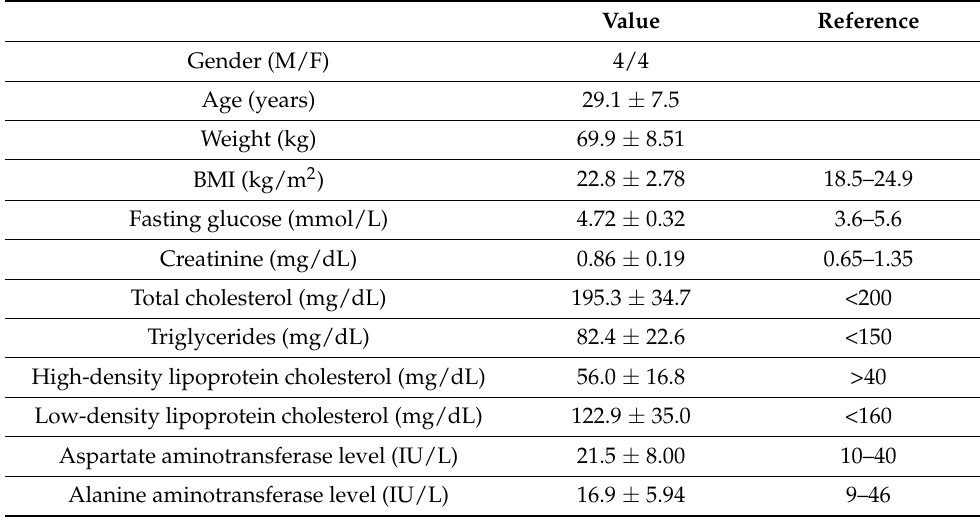
Table 1. Subject characteristics. Data are mean ±